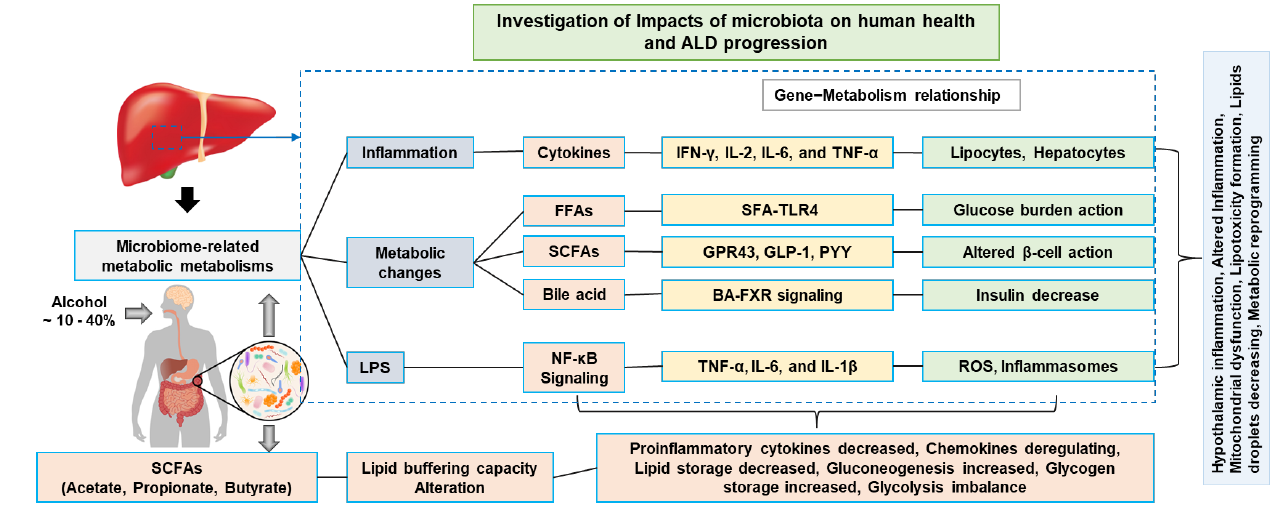
Figure 3. Proposed pathogenic mechanisms of ALD. An alcohol-induced liver metabolic intracellular imbalance through gut–liver axis. LPS, lipopolysaccharide; FFAs, free fatty acids; SCFAs, short-chain fatty acids.